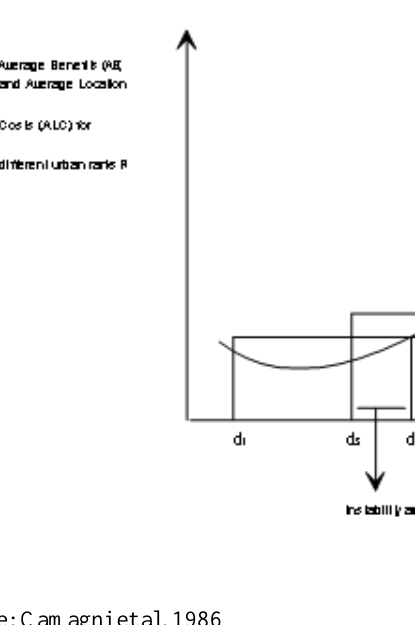
Figure 1: Efficient Urban Size for Different Urban